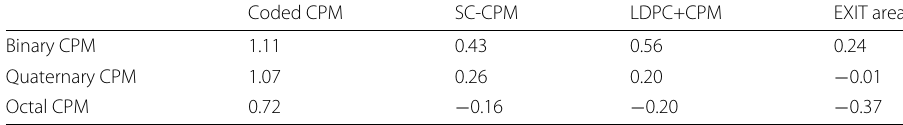
Table 1 Thresholds E b / N 0 in decibel for different schemes at rates close to 1 / 2